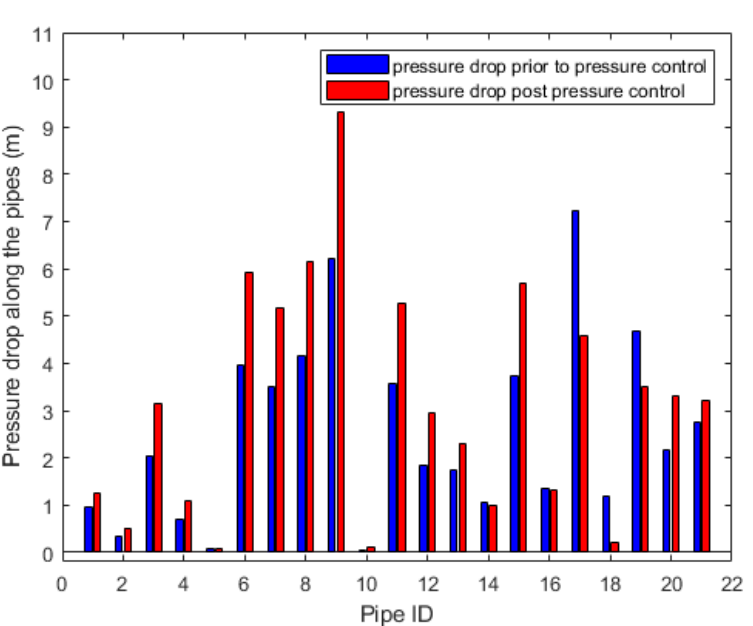
Figure 4. Nodal pressure heads for case study